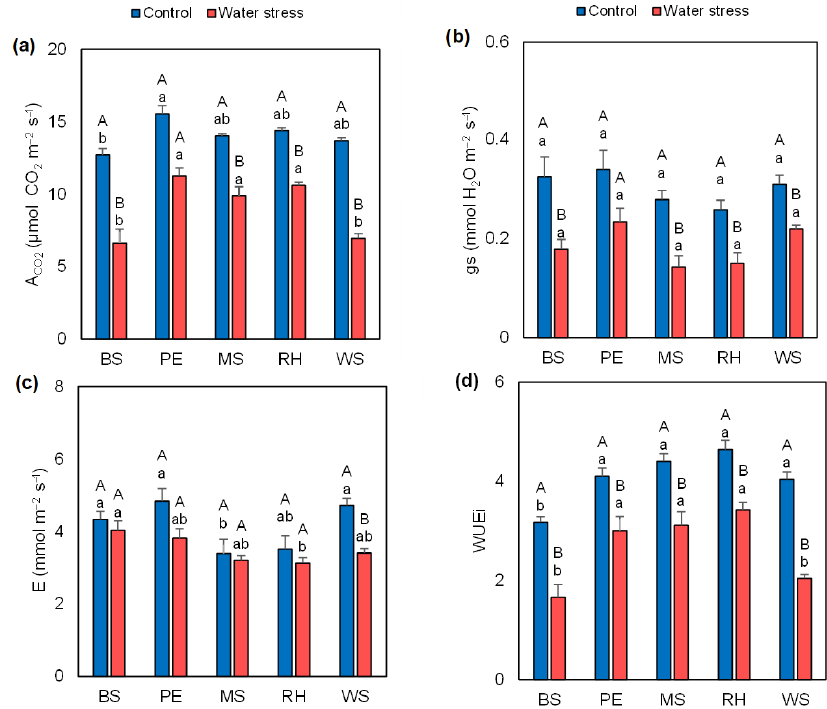
Figure 1. ( a ) Net CO 2 fixation rate (Amax), ( b ) stomatal conductance (gs), ( c ) transpiration rate (E), and ( d ) water-use efficiency (WUEi) in artichoke plants of the commercial Symphony variety non- mulched or subjected to different mulching treatments and cultivated under control (well-watered) and water-stress (70% ETc) conditions. Bars show the means of five plants ± standard error. Different capital letters indicate significant differences due to the water-stress treatment, while different small letters show significant differences among mulching treatments according to Tukey’s test ( p ≤ 0.05). Abbreviations used: bare soil (BS), polyethylene mulch (PE), mushroom-substrate-based hy-